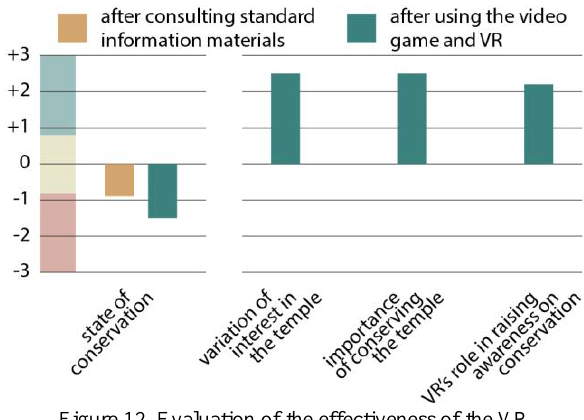
Figure 12. Evaluation of the effectiveness of the